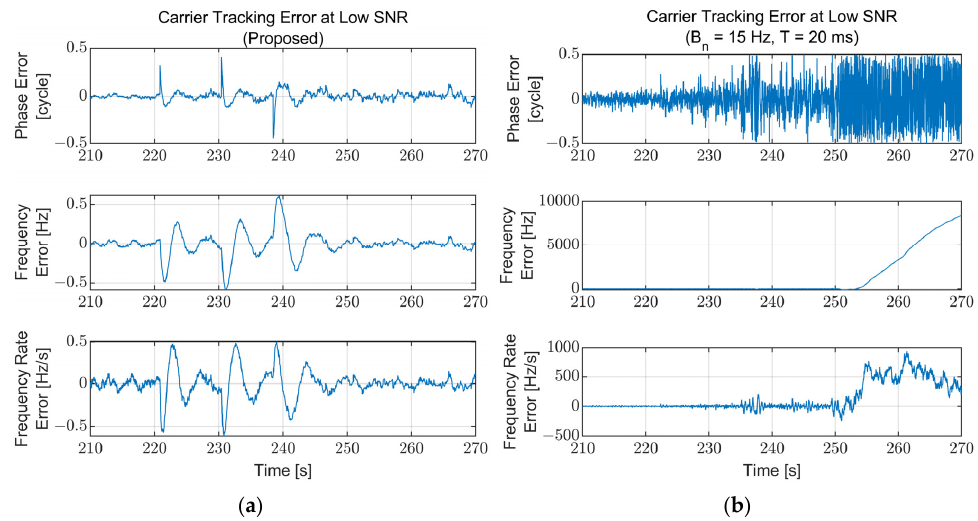
Figure 14. Carrier tracking error at the low SNR region (210–270 s): ( a ) Proposed algorithm; ( b ) Fixed bandwidth (B n = 15 Hz, T = 20 ms). The fixed-bandwidth loop loses lock at approximately 253 s (C/N 0 = 17 dB-Hz) while the proposed algorithm maintains its lock.